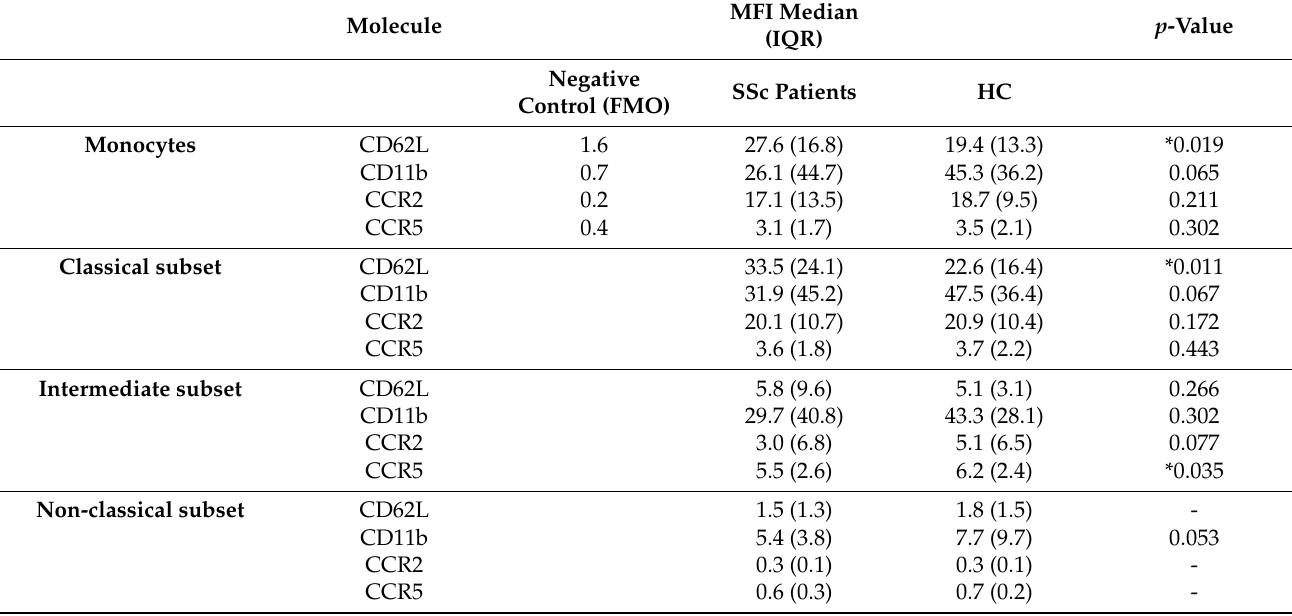
Table 3. The MFI of surface adhesion and chemotactic molecules on monocytes and monocyte